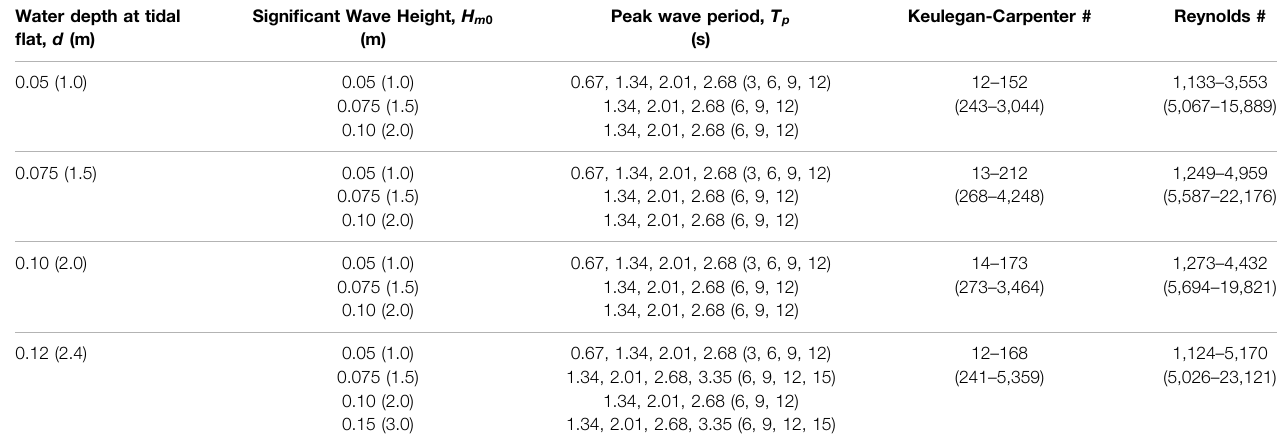
TABLE 3 | Range of irregular wave